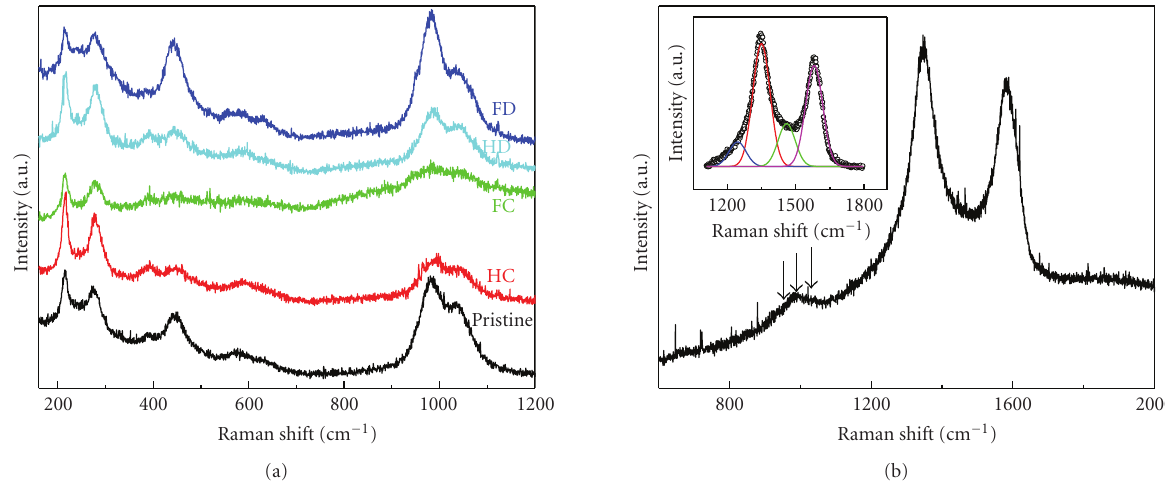
Figure 4: (a) Raman spectra of C- LiFePO 4 powder at various stages of charge – discharge process (half charge(HC), full charge(FC), half discharge(HC) and full discharge(FD)) in frequency range 150 to 1200 cm − 1 . (b) Raman spectra of C- LiFePO 4 powder in the frequency range 600 to 1800 cm − 1 (inset presents resolved Raman spectra of the residual carbon using Gaussian distribution